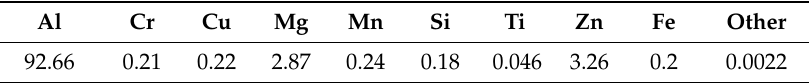
Table 2. Chemical composition of the Al 7075 alloy used in this study